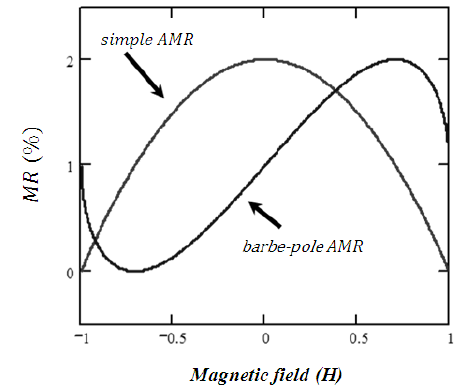
Figure 2. R-H characteristic of a simple AMR sensor and barber-pole AMR f